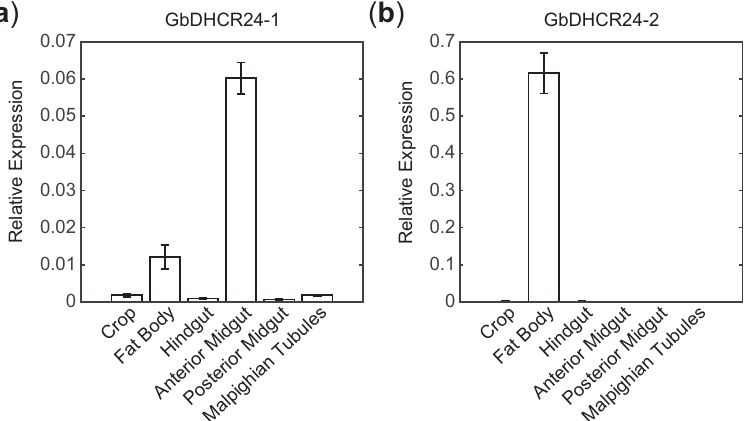
Figure 3. Tissue distribution of GbDHCR24s. Relative transcriptional level of ( a ) GbDHCR24-1